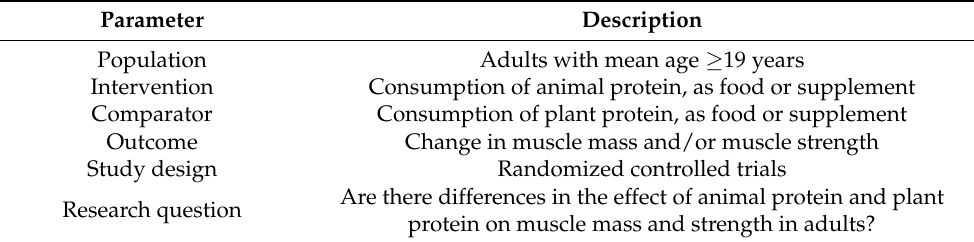
Table 1. Population, intervention, comparison, outcome and setting (PICOS) criteria used to define the research